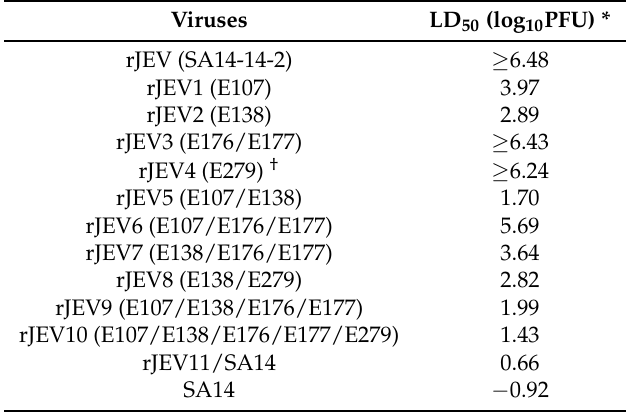
Table 2. Neurovirulence of the mutated viruses in 3-week-old mice inoculated by the i.c. route.